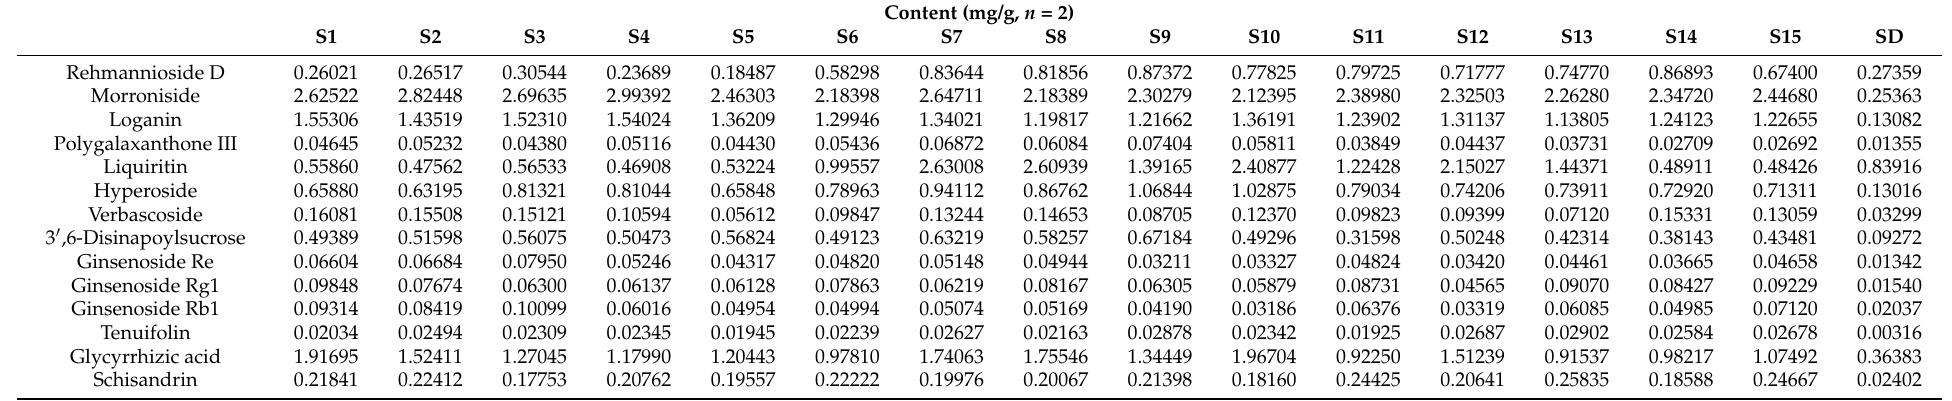
Table 8. Content determination results of 14 analytes in fifteen batches of GYJ